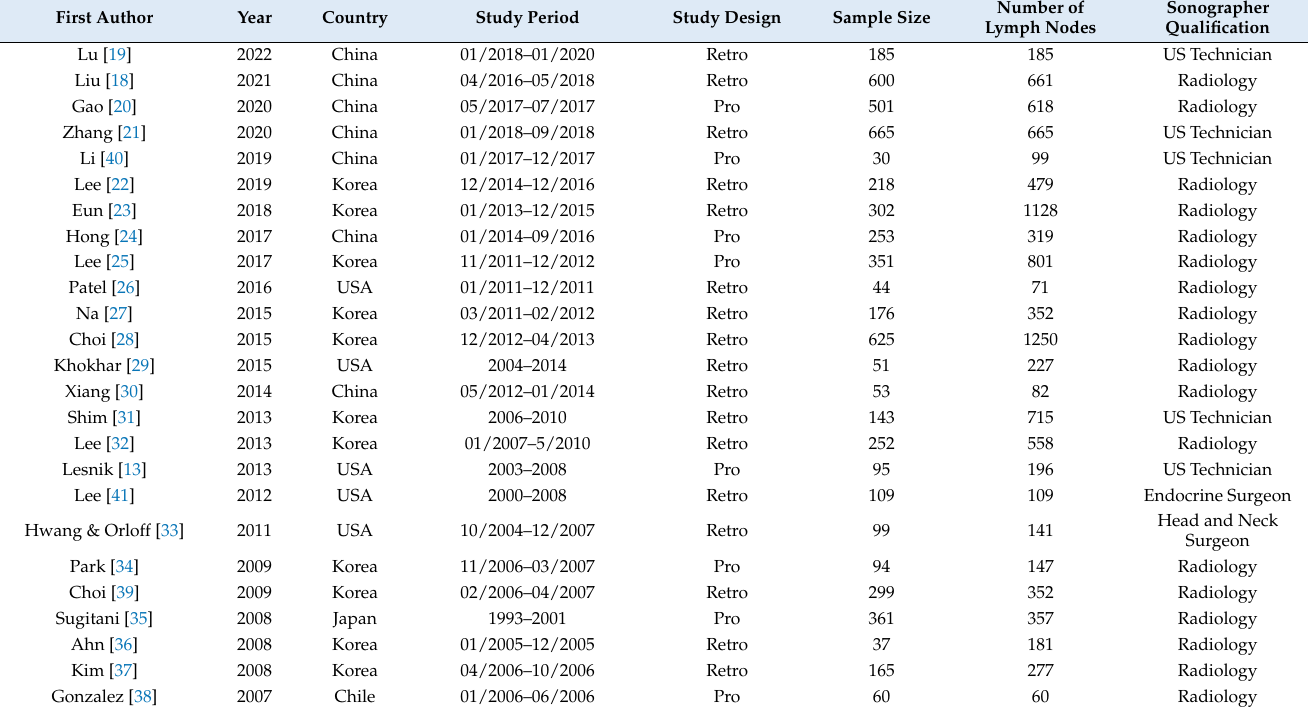
Table 1. Characteristics of the study population.